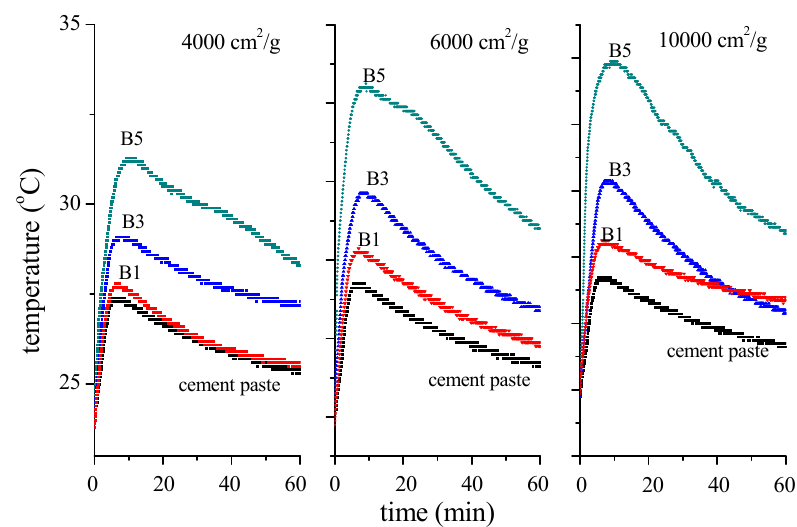
Figure 5. Hydrated temperature of BOFS samples of various specific surface areas.